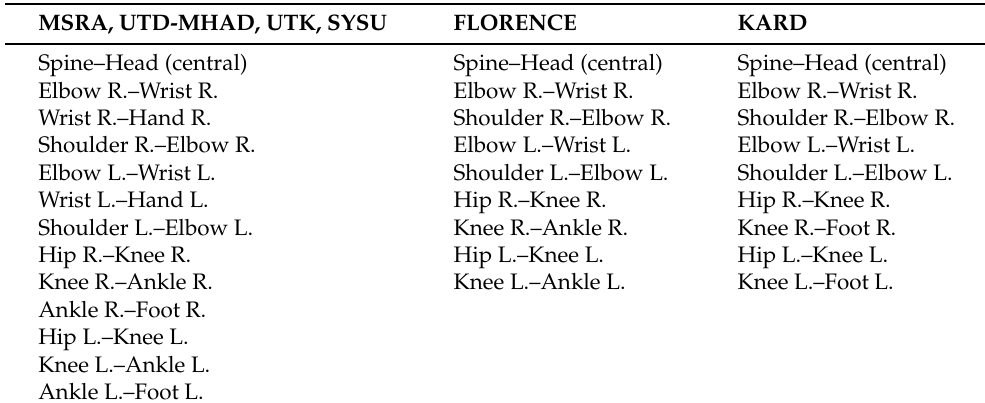
Table 2. Subsets of joints used for the Distance Descriptor. “L.” and “R.” denote Left and Right, respectively. Hand L. Wrist L. Hand L. Hand R. Wrist R. Hand R. Shoulder L. Shoulder L. Shoulder L. Shoulder R. Shoulder R. Shoulder R. Head Head Head Spine Spine Spine Hip L. Hip L. Hip L. Hip R. Hip R. Hip R. Ankle L. Ankle L. Foot L. Ankle R. Ankle R. Foot R.